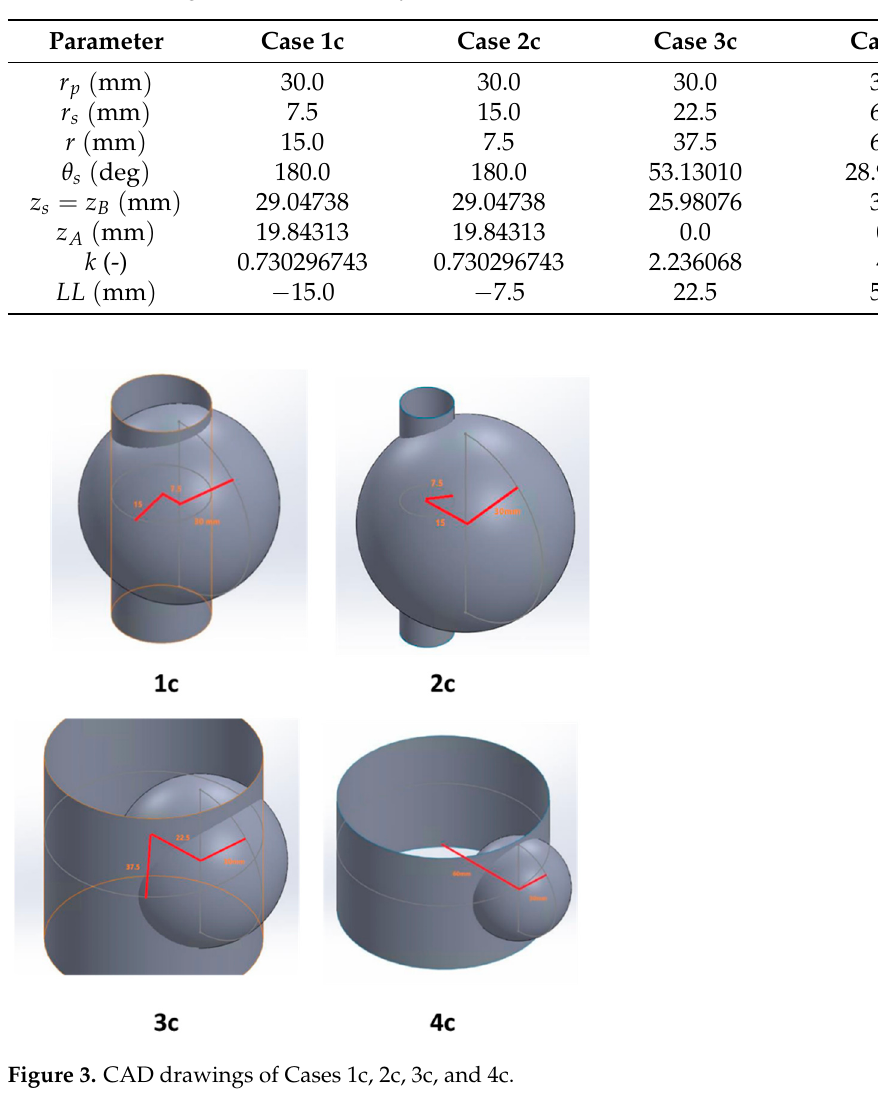
Table 1. Test configurations for the analyses.